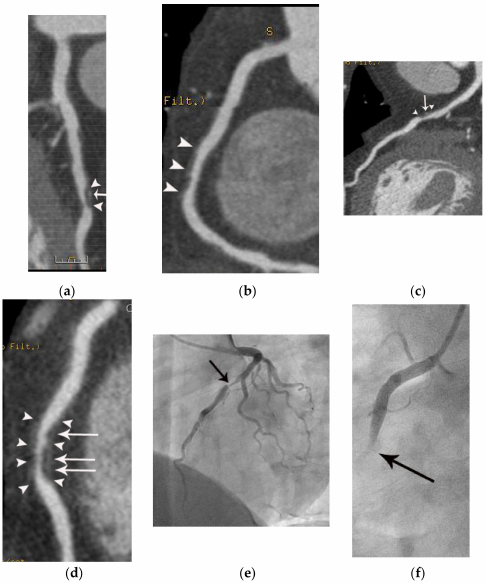
Figure 10. A 46-year-old man presenting with ACS. Coronary CTA was obtained due to multiple cardiac risk factors. Approximately 70% stenoses with mixed plaque ( a ) and 40–50% stenosis with noncalcified plaque ( b ) are noted in the mid left anterior descending and mid right coronary artery, respectively. At the 12-month follow-up coronary CTA, the stenosis in the mid left anterior descending coronary artery shows no definite change ( c ). In contrast, note the progression of plaque ( d ) in the mid right coronary artery in the degree of coronary stenosis (about a 70% stenosis), the increase in the positive remodeling index (arrowheads in ( d )) and the low-attenuation plaque/napkin ring sign (arrows in ( d )). Invasive coronary angiography was recommended in this patient, but the patient refused and was lost to follow-up. He presented to the ED with acute chest pain 2 months later. Emergent coronary angiography showed total occlusion indicating a culprit lesion in the same location as the vulnerable plaque in the mid right coronary artery (arrow in ( f )). In contrast, the stenosis in the proximal middle left anterior descending coronary artery (nonculprit lesion) showed no interval change (arrow in ( e